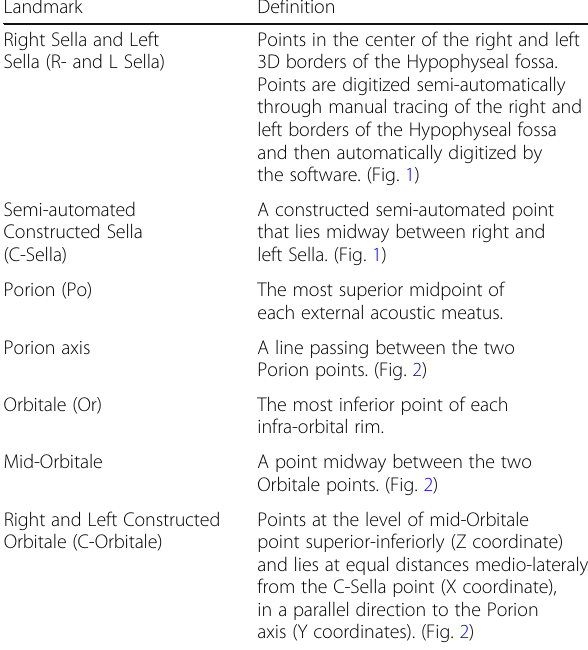
Table 1 Landmark definition for use in reference system Landmark